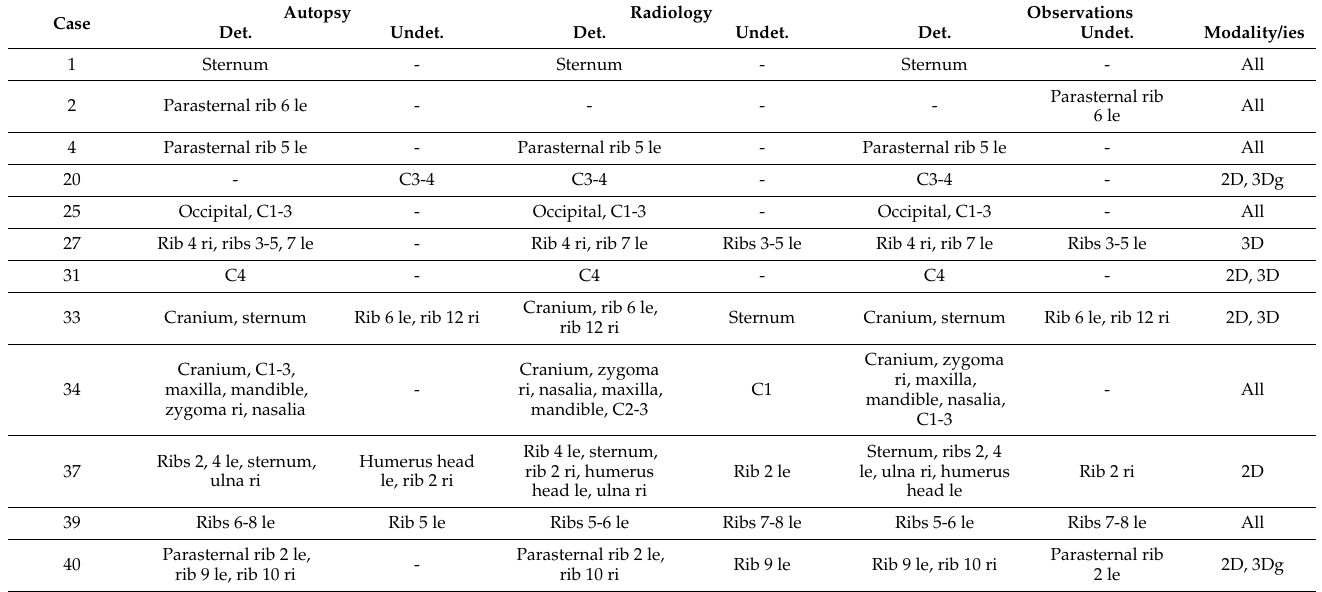
Table 4. Detected (det.) and undetected (undet.) bone lesions in the autopsy and radiology reports and our observations; modality/ies with best outcome.